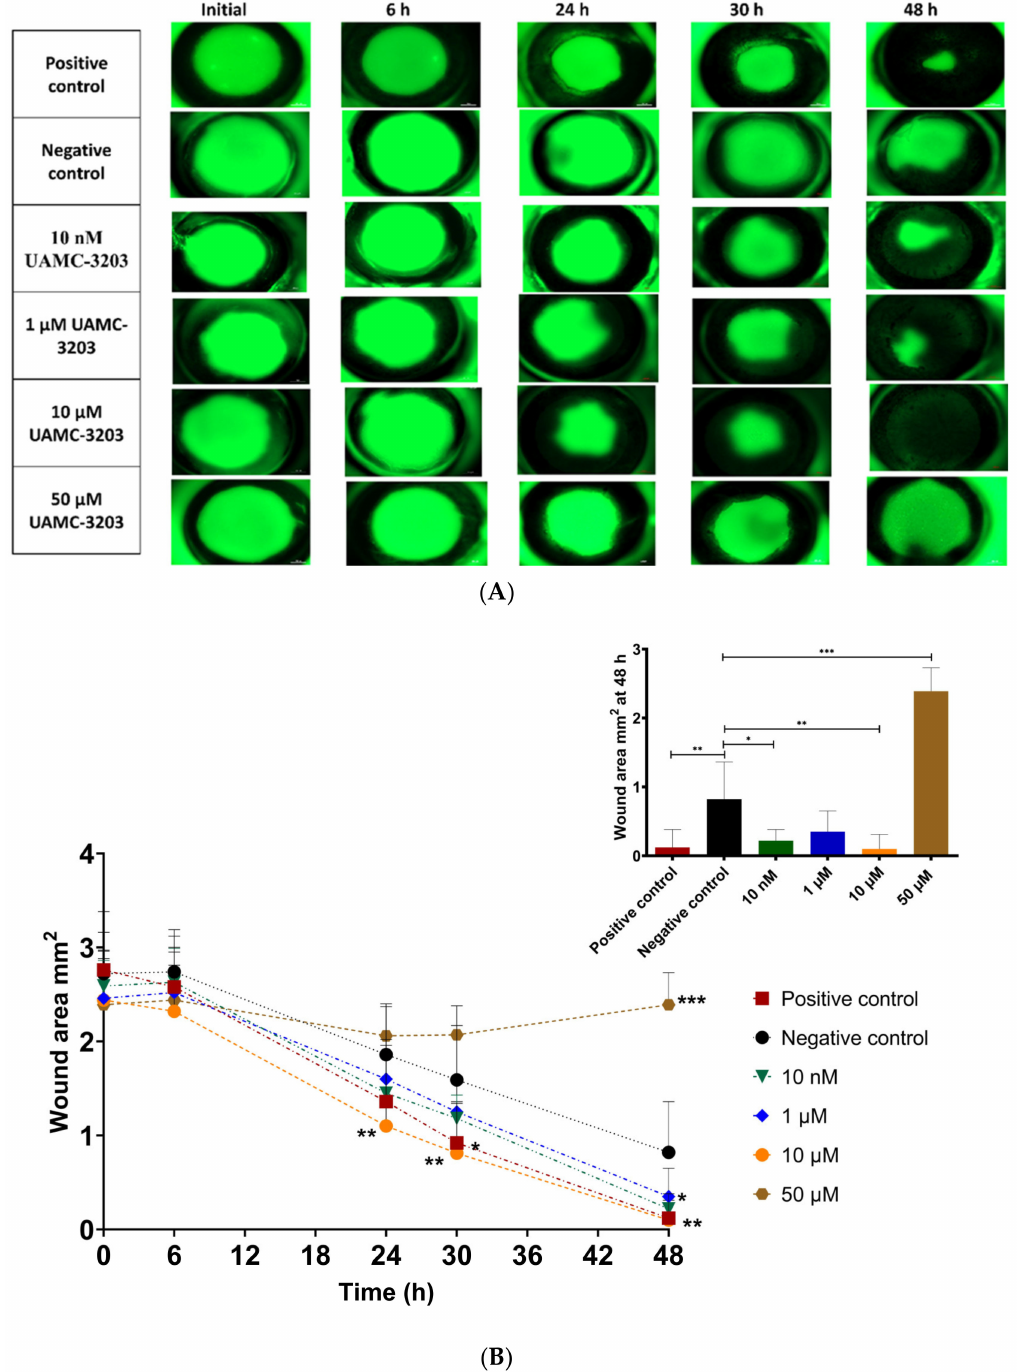
Figure 4. ( A ) Representative corneal photographs following fluorescein staining, and ( B ) measure- ment of the corneal epithelial wound areas (mm 2 ) of alkali-wounded corneas treated with DMEM medium supplemented with FBS (positive control), serum-free medium (negative control), and UAMC-3203 at concentration 10 nM, 1 µ M, 10 µ M, and 50 µ M at five time points during wound healing (decrease in wound area). Statistical analysis was performed by two-way ANOVA compared to negative control with Bonferroni t -test: * p < 0.05, ** p < 0.01, and *** p < 0.001 ( n =